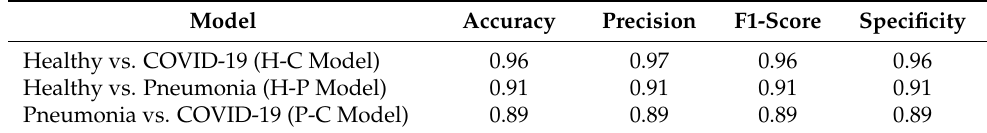
Table 4. Results for